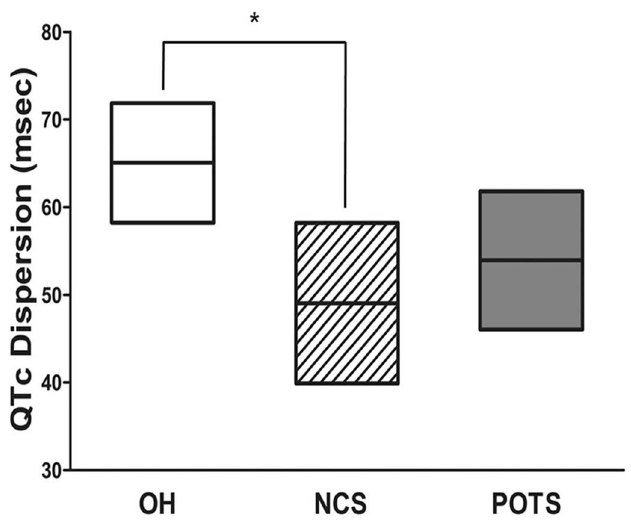
Figure 2. QTc dispersion results. Comparisons of the QTc dispersion showed significant differences between groups ( p =0.021). Post-hoc analysis revealed that patients with orthostatic hypotension (OH) had more increased QTc dispersion than patients with neurocardiogenic syncope (NCS) (uncorrected p =0.037, age and gender-corrected p =0.013). The top and bottom borders of the boxes represent the upper and lower limits of the 95% CI range, respectively. The horizontal lines in the middle represent the mean value. Asterisk (*) indicates significant results after correction for post-hoc comparisons. doi:10.1371/journal.pone.0106417.g002 HRDBs (10.3 6 6.0 beats/min) than NCS ( p = 0.006) or POTS